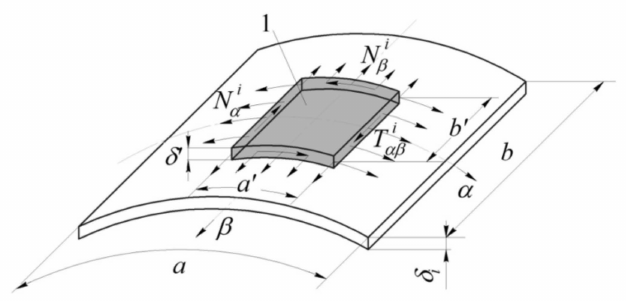
Figure 5. Approximation of displacements within the i –th layer: 1—area of temperature changes in the i -th